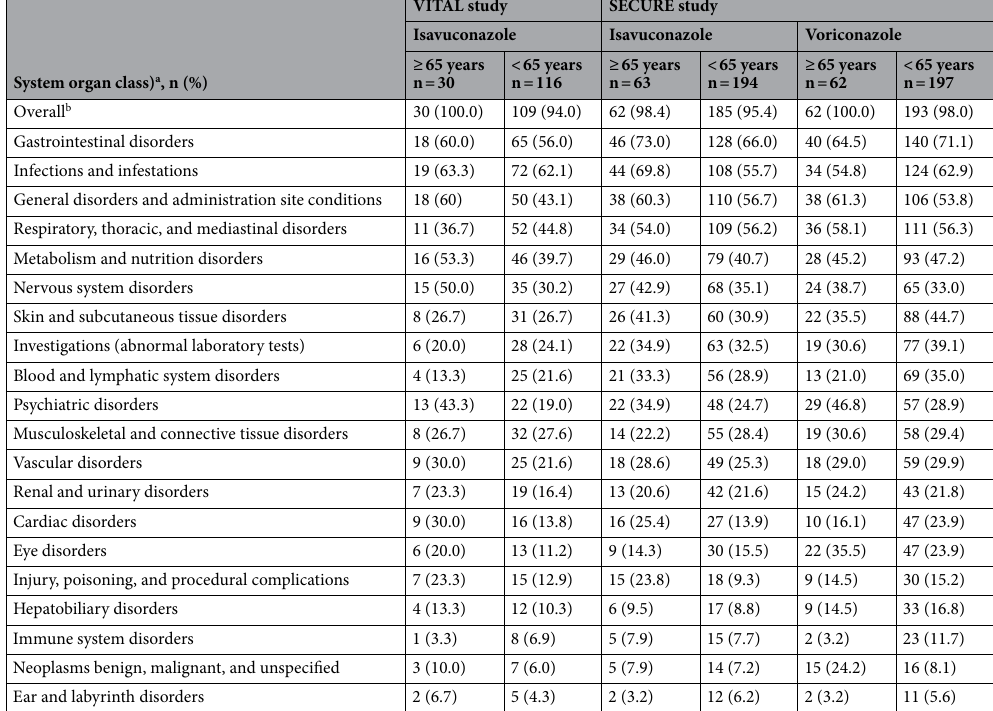
Table 4. Treatment-emergent adverse events by system organ class (safety population). Treatment-emergent AE is an AE starting after the first study drug administration until 28 days after the last dose of the study drug. AE adverse events. a System organ classes with most frequent AEs or AEs of special interest are listed. b Overall: Total number of patients who had treatment-emergent